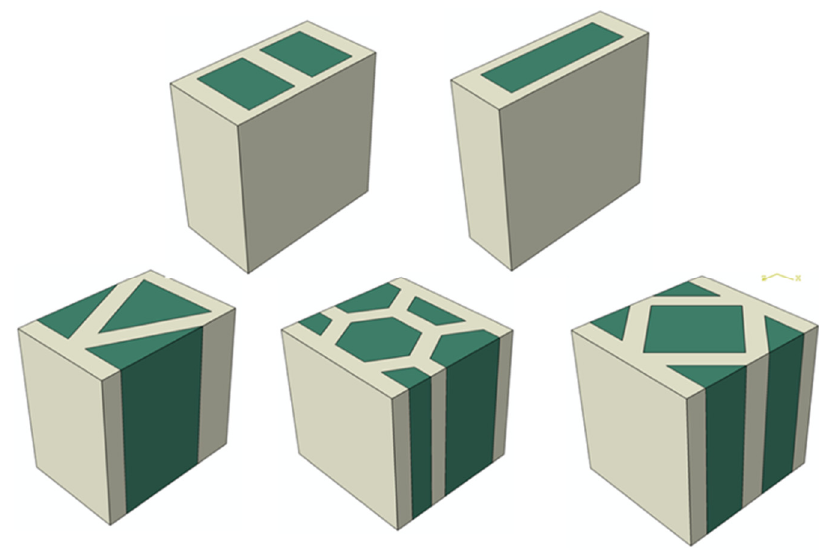
Figure 3. The unit cells of the 3DP concrete wall for the different shapes considered.